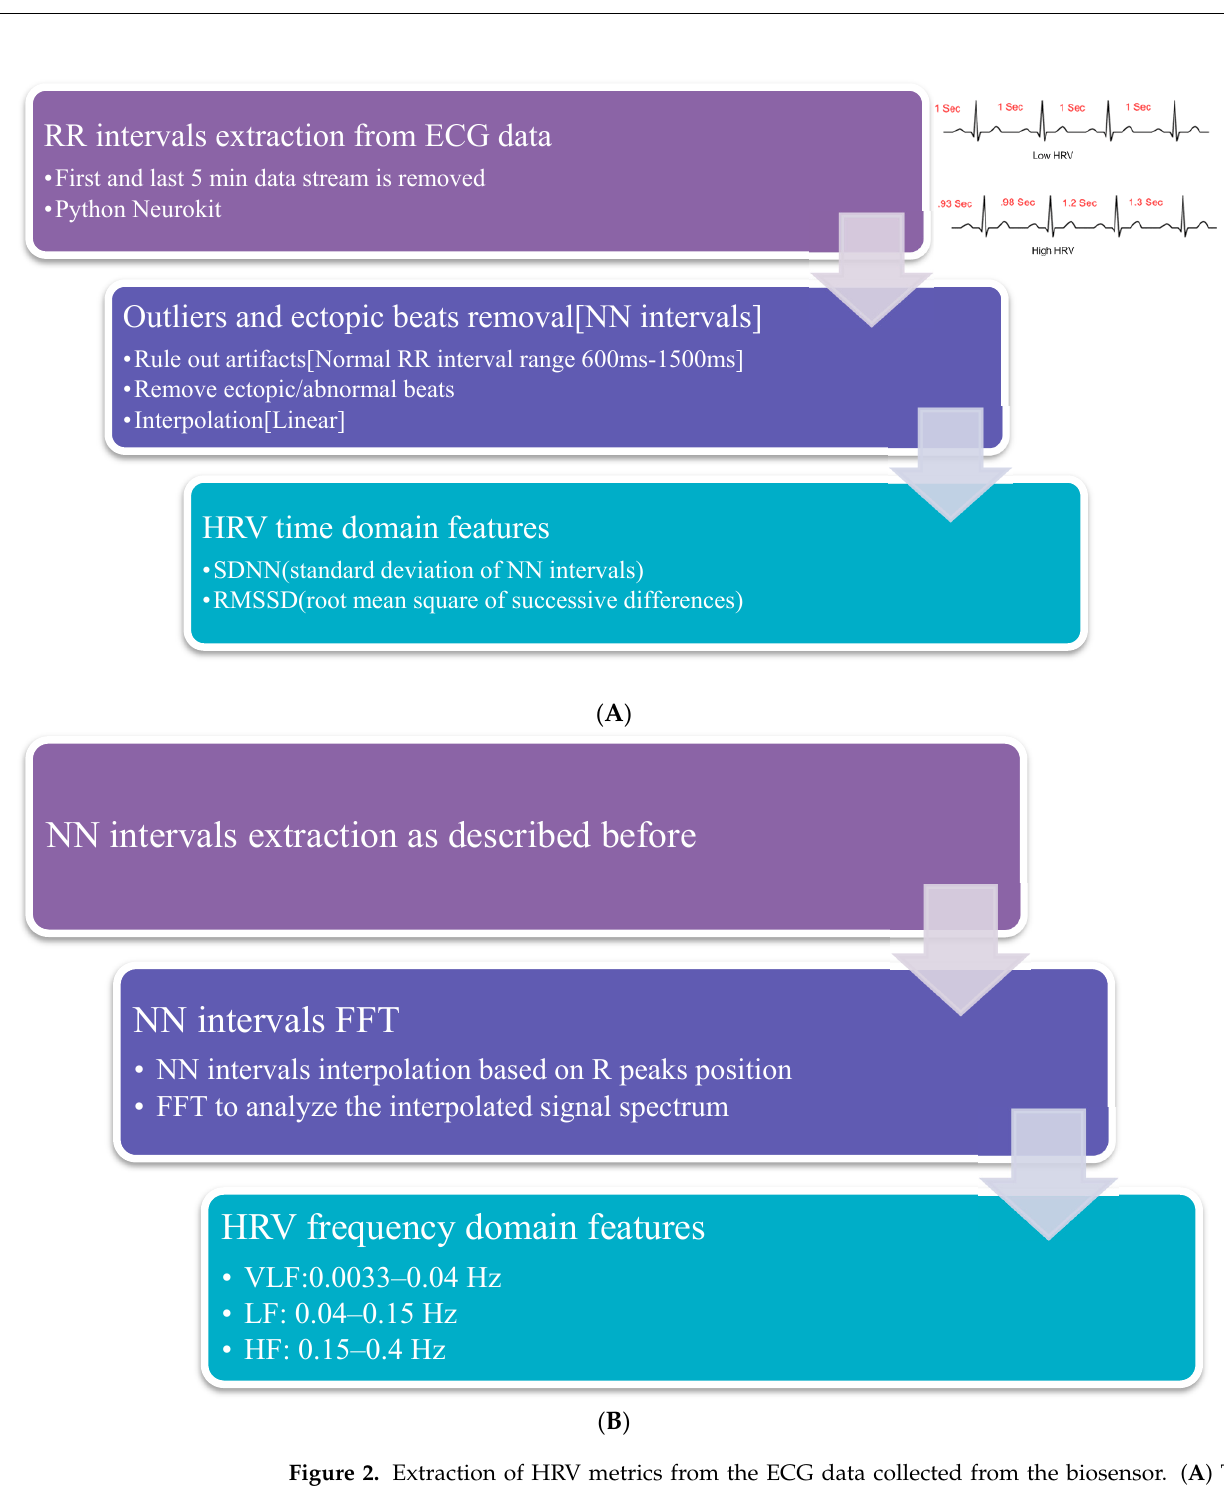
Figure 2. Extraction of HRV metrics from the ECG data collected from the biosensor. ( A ) Time domain metrics. ( B ) Frequency domain metrics.